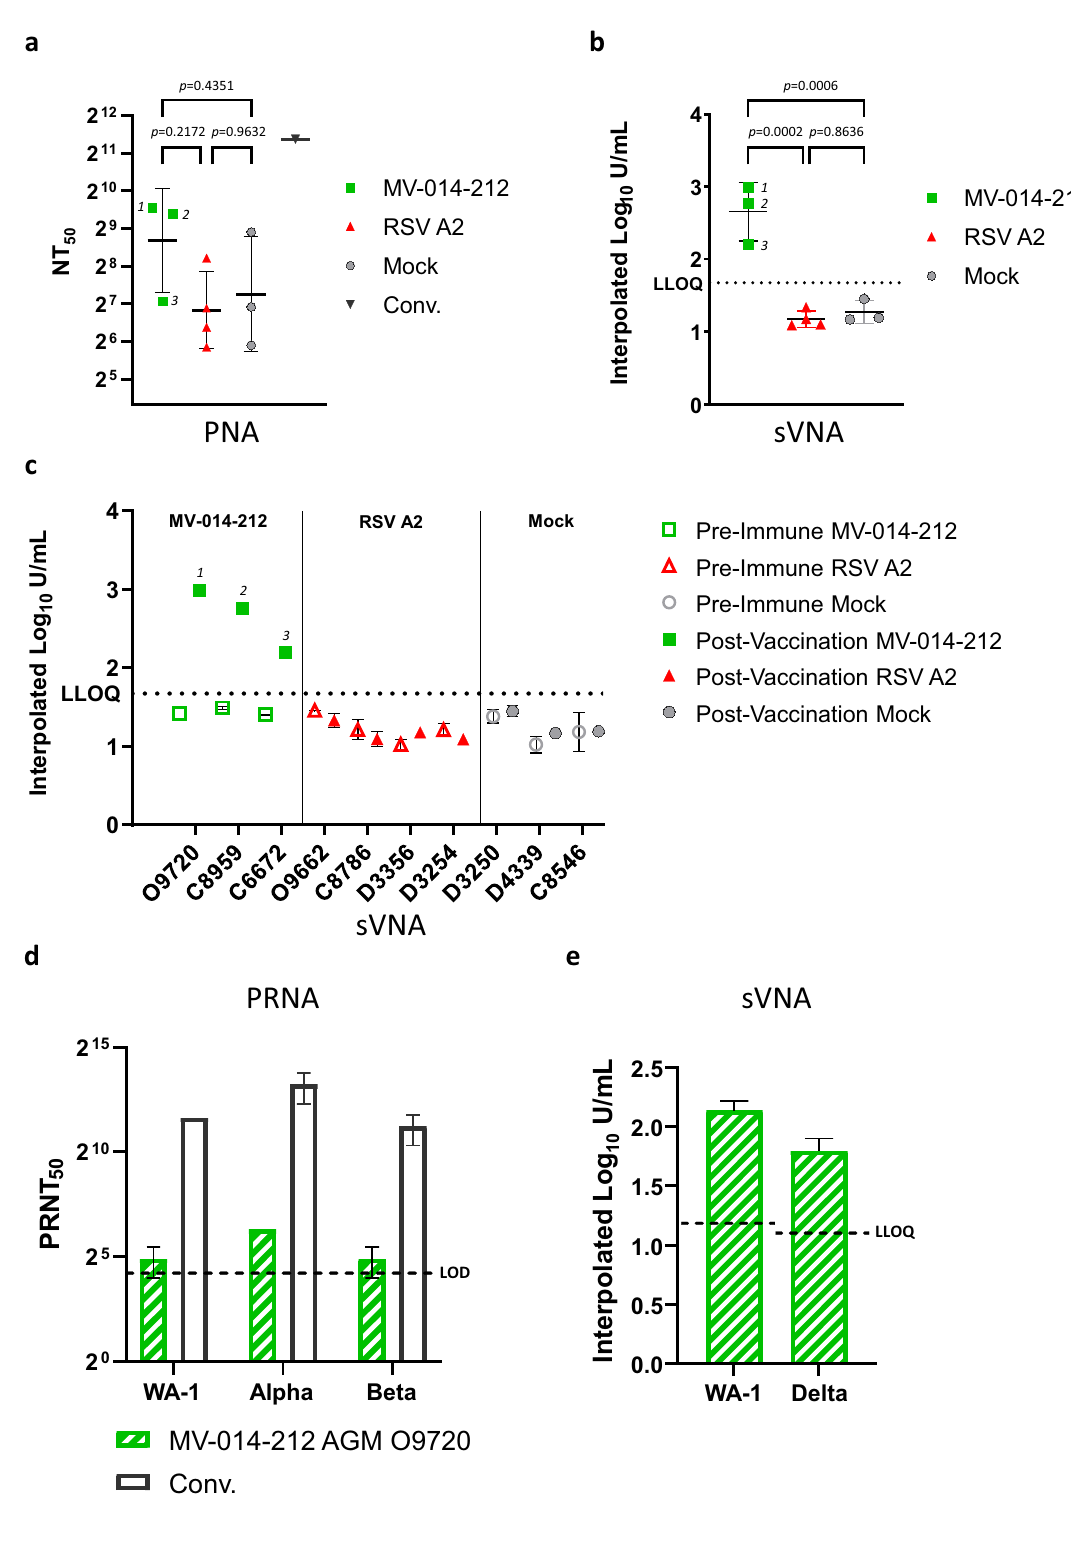
The PRNA detected a neutralizing response against two variants of concern, Beta (B.1.351) and Alpha (B.1.1.7), as well as the USA- WA1/2020 strain, while the sVNA showed that Spike-speci fi c antibodies elicited by MV-014-212 also neutralized the Delta variant (B.1.617.2). However, the small number of animals in these studies limited the statistical interpretation of the